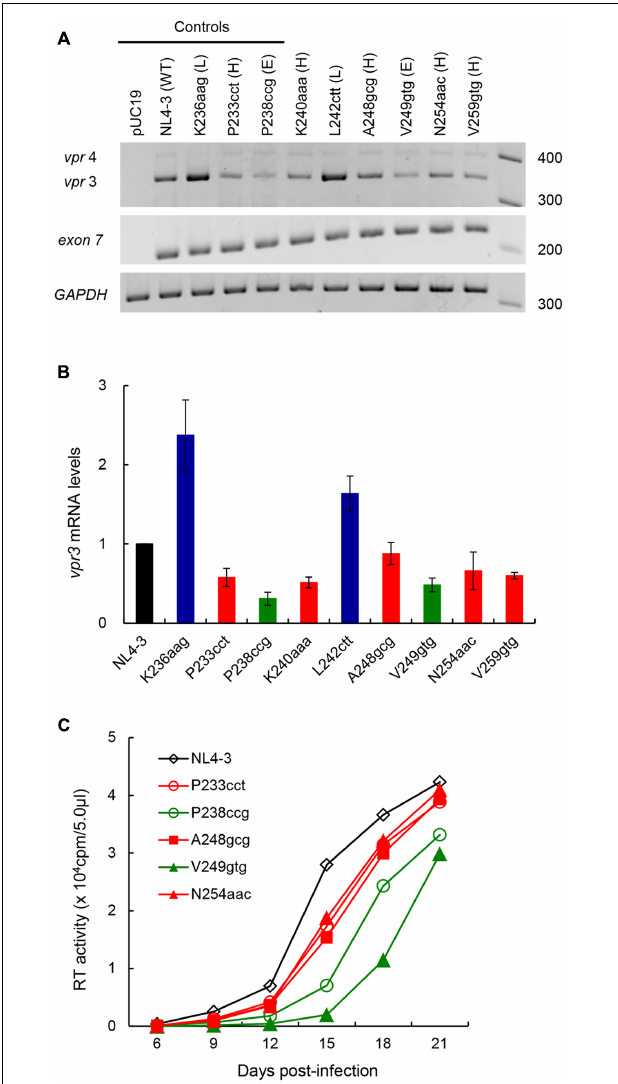
FIGURE 4 | Effects of vif -affecting nSNVs on vpr expression and virus replication. (A) Vpr expression pattern. Semiquantitative PCR was carried out using a specific primer set for vpr mRNAs ( Figure 1 ), and cDNA samples were prepared as described in Figure 3 . NL4-3 and K236aag/P233cct/P238ccg clones were used as a parental clone and as standard control clones for low (L)/high (H)/excessive (E) vif types (Nomaguchi et al., 2016), respectively. Expression levels of all HIV-1 mRNA species (exon7) and GAPDH mRNA were analyzed by semiquantitative PCR in parallel as transfection and internal controls, respectively. RNA size markers in nucleotides are indicated on the right. Representative data from four independent experiments are shown. (B) Quantification of vpr expression level. Signal intensities of semiquantitative RT-PCR products were quantitated by Amersham Imager 600 instrument. Intensity of vpr3 mRNA in each sample was normalized by those of all HIV-1 mRNA species (exon 7) and GAPDH mRNA. Normalized mRNA intensity in each sample relative to that of NL4-3 is presented. Mean values ± SD from four independent experiments are shown. (C) Viral growth kinetics in CEM-SS cells. Viruses were prepared from 293T cells transfected with proviral clones indicated, and equal units of reverse transcriptase activity (10 4 ) were inoculated into CEM-SS cells (10 5 ). Virus replication was monitored by reverse transcriptase activity released into the culture supernatants. The results shown were reproduced in another independent